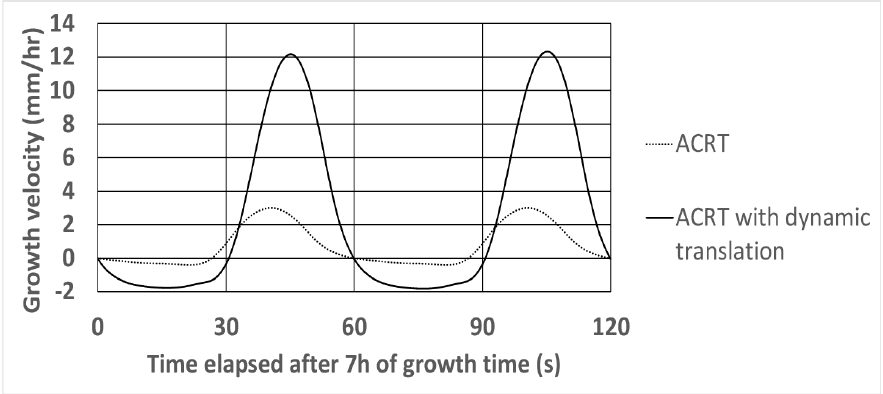
Figure 7. Growth velocity variation at the centerline during a single ACRT cycle at t = 7 h.